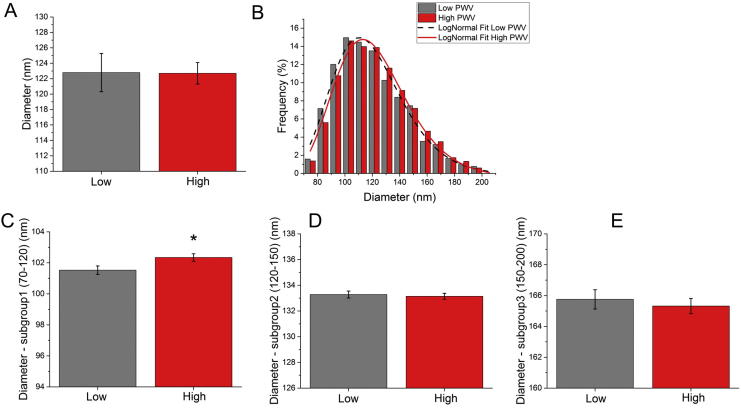
Collagen fibril diameter in the low and high PWV groups (A) Bar graph showing mean ± SEM (n = 7 and n = 9 patients in the low and high group) (B) Distribution of diameters in the two groups (n = 3228 and 4141 measurements in the low and high PWV groups respectively). The distributions were statistically different. (C)–(E) Diameter values shown in 3 sub-groups; 70–120 nm (C), 120–150 nm (D) and 150–200 nm. There was a statistically significant difference in the low sub-group, 70–120 nm (non-parametric Mann-Whitney U test, adj p-value = 0.049).